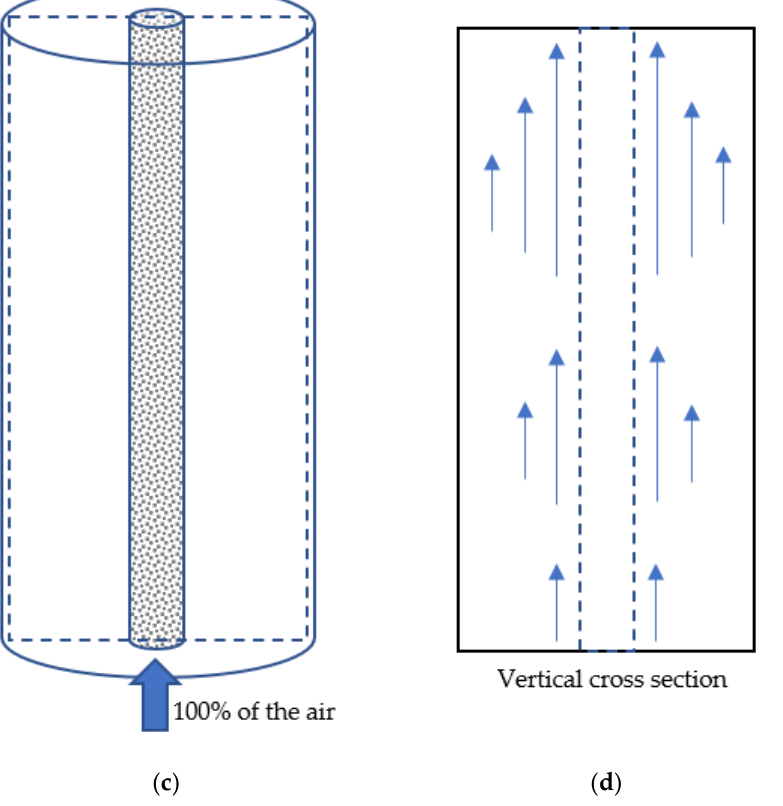
Figure 7. Strategies for aerating packed-bed bioreactors used by Perez et al. [61]. ( a ) Split aeration; ( b ) Approximate airflow patterns for split aeration; ( c ) Radial aeration; ( d ) Approximate airflow patterns for radial aeration, assuming even flow through the walls of the perforated pipe along the length (true flow patterns will depend strongly on the design of the perforations).